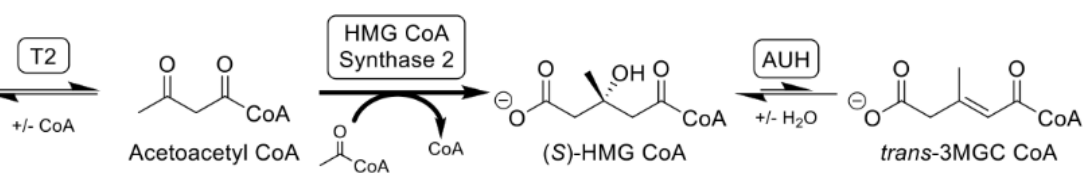
Figure 2. The acetyl CoA diversion pathway in secondary 3MGC acidurias. When IEMs occur in genes that affect mitochondrial membrane structure, ETC function or ATPase subunits, acetyl CoA entry to the TCA cycle slows. When this occurs, acetyl CoA is diverted to trans -3MGC CoA in three enzyme-mediated steps. Initially, acetoacetyl CoA thiolase (T2) catalyzes a Claisen condensation between two acetyl CoA, yielding acetoacetyl CoA and free CoA. Following this, HMG CoA synthase 2 catalyzes a second Claisen condensation between acetoacetyl CoA and acetyl CoA, yielding ( S )- HMG CoA and free CoA. This intermediate is then dehydrated to trans -3MGC CoA by the leucine catabolism pathway enzyme,